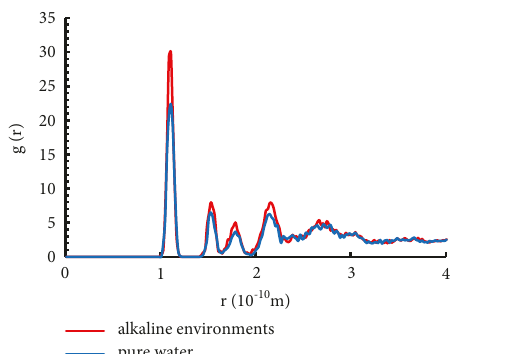
Figure 7: Radial distribution functions of the calcium and PVC.